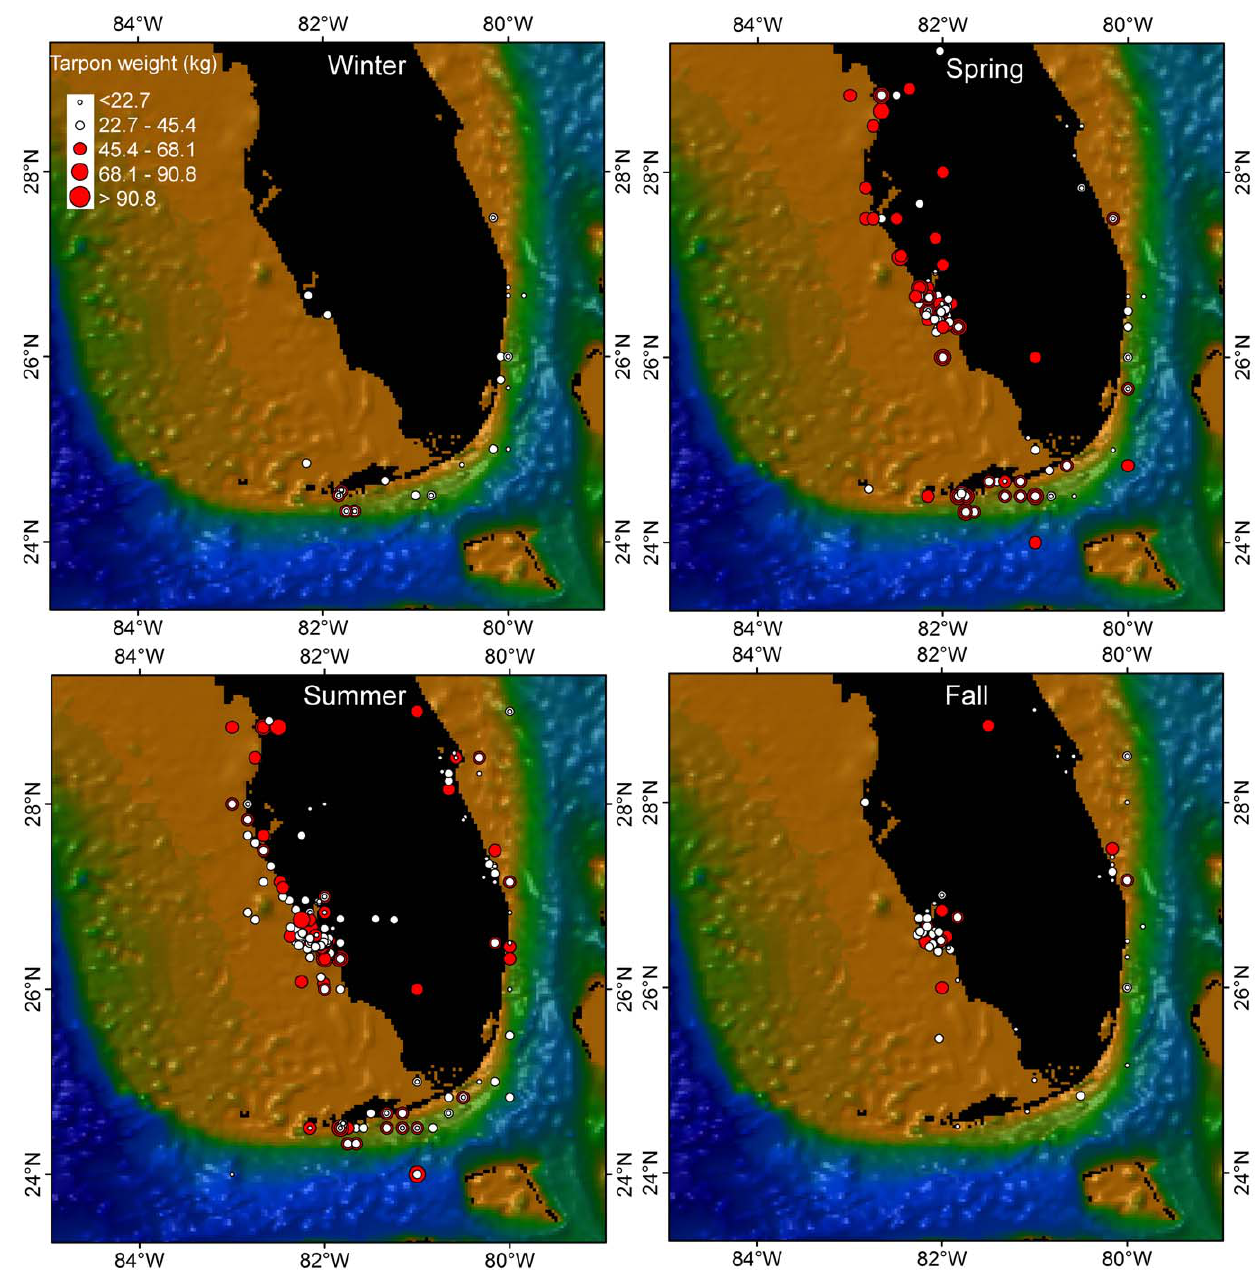
Figure 5. Release locations of conventionally tagged Atlantic tarpon in South Florida from 1962 to 2004 in Winter (a), Spring (b), Summer (c), and Fall (d). The sizes of the tagged tarpon were grouped into 5 weight classes ( , 22.7, 22.7–45.4, 45.4–68.1, 68.1–90.8, . 90.8 kg) are indicated by the size of dots as shown in the legend. Tarpon , 90.8 kg were indicated by white dots, and . 90.8 kg were indicated by red dots. Winter: Dec, Jan, Feb; Spring; Mar, Apr, May; Summer; Jun, Jul, Aug; Fall: Sep, Oct,